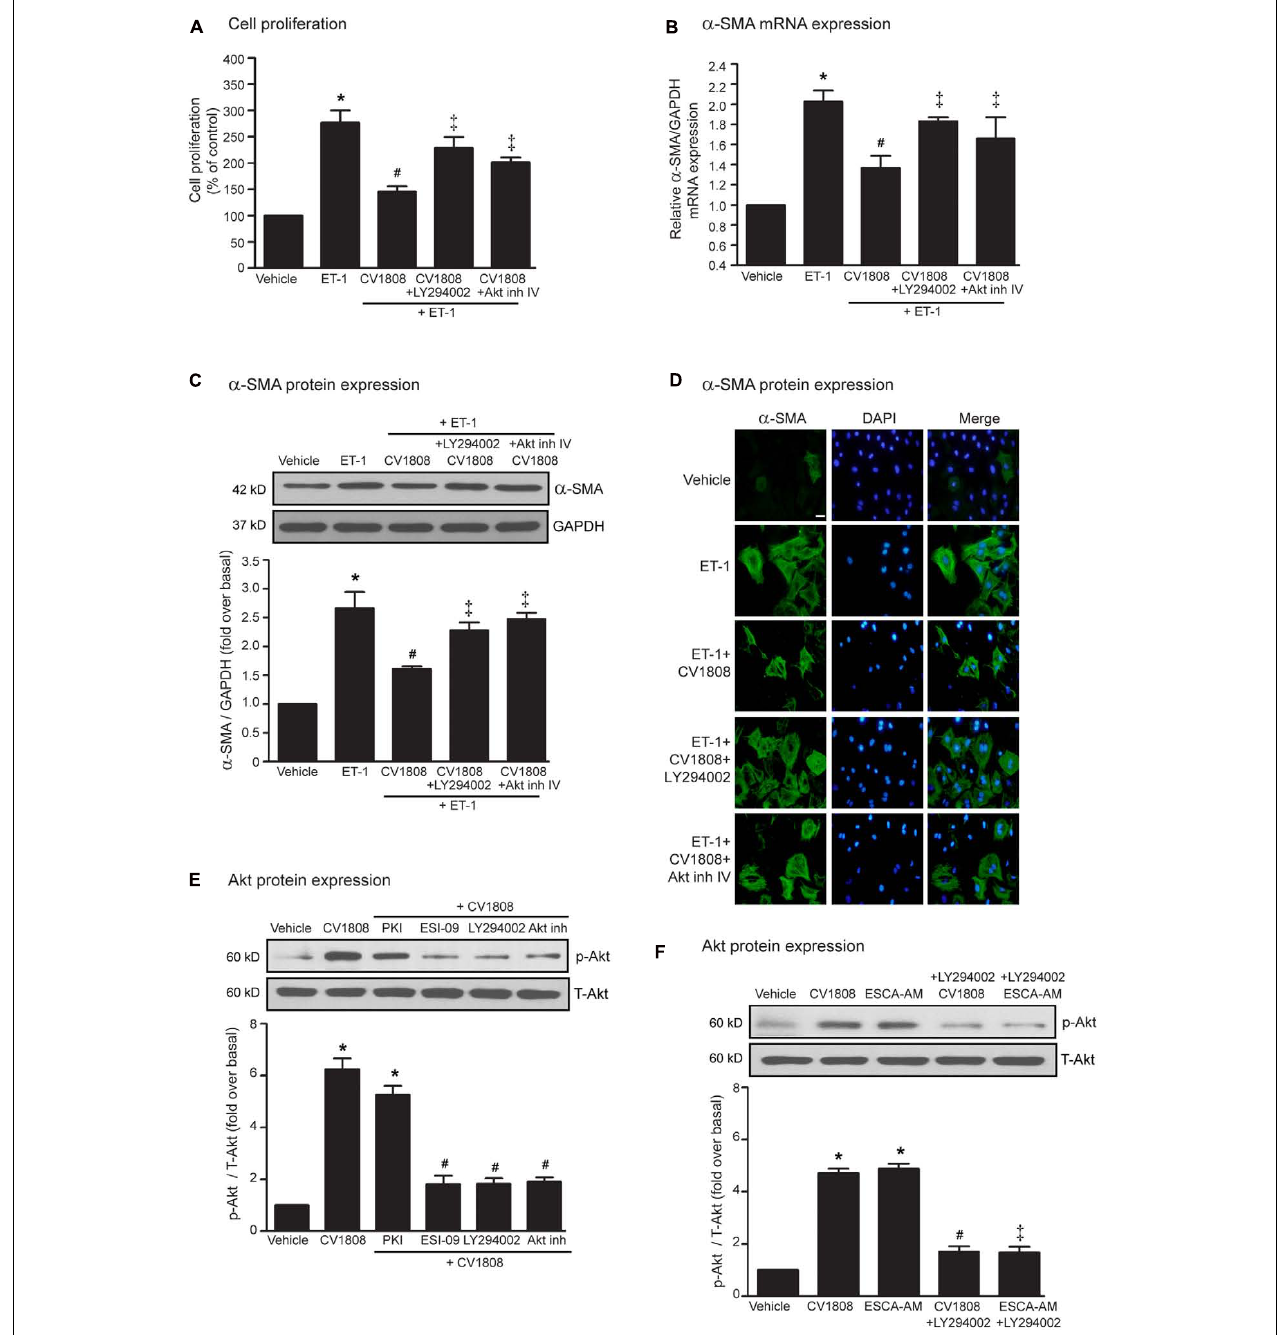
FIGURE 5 | Stimulation of A 2 receptors exhibits antifibrotic effects through PI3K/Akt-dependent pathway. (A–D) Cardiac fibroblasts were pretreated without or with either 10 µ M LY294002 (PI3K inhibitor) or 1 µ M Akt inh (Akt inhibitor IV) for 1 h. After 1 h, cells were treated with vehicle (control), or 10 µ M CV1808 for 1 h and further stimulated with 20 nM ET-1 for 12 h (B) or 24 h (A,C,D) at 37 ◦ C. (A) Cell proliferation was quantified by MTT assay. The data were expressed as the percentage relative to the non-treated group, and shown as mean ± SEM ( n = 4). ∗ P < 0.05 vs. vehicle; # P < 0.05 vs. ET-1; ‡ P < 0.05 vs. ET-1+CV1808. (B,C) Relative α -SMA mRNA (B) and protein (C) levels were quantified and shown as the mean ± SEM ( n = 4). ∗ P < 0.05 vs. vehicle; # P < 0.05 vs. ET-1; ‡ P < 0.05 vs. ET-1+CV1808. (D) Cells were incubated with anti- α -SMA antibody followed by goat anti-mouse antibody (Alexa Fluor 488). The α -SMA was visualized by fluorescent microscope. Cells were stained for α -SMA (green) and nuclear staining of nucleus with DAPI (blue). Bar, 10 µ m. (E) Cells were pretreated without or with 10 µ M PKI, 10 µ M ESI-09, 10 µ M LY294002 or 10 µ M Akt inhibitor for 1 h before treatment with vehicle (control), or 10 µ M CV1808 for 30 min at 37 ◦ C. (F) Cells were pretreated with 10 µ M LY294002 for 1 h before treatment with either 10 µ M ESCA-AM, or 10 µ M CV1808 for 30 min at 37 ◦ C. (E,F) Cell lysates were immunoblotted with anti-phospho-Akt and anti-Akt antibodies. The Akt activation was quantified, expressed as fold increase over vehicle, and shown as the mean ± SEM ( n = 4). ∗ P < 0.05 vs. vehicle; # P < 0.05 vs. CV1808; ‡ P < 0.05 vs.